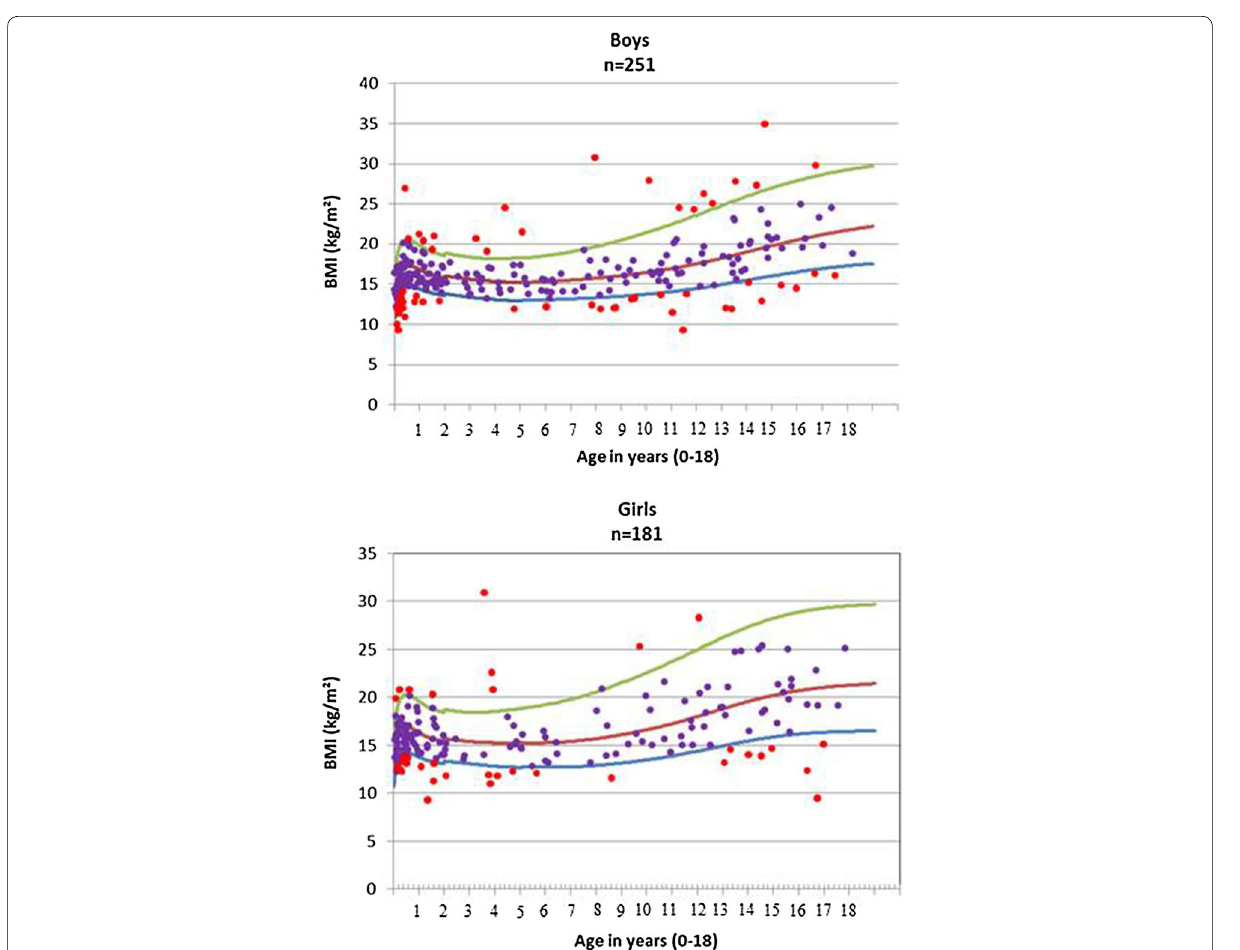
Fig. 2 Body mass index (BMI) distribution among girls and boys, according to WHO references (curves represent respectively). SD: standard deviation for age and